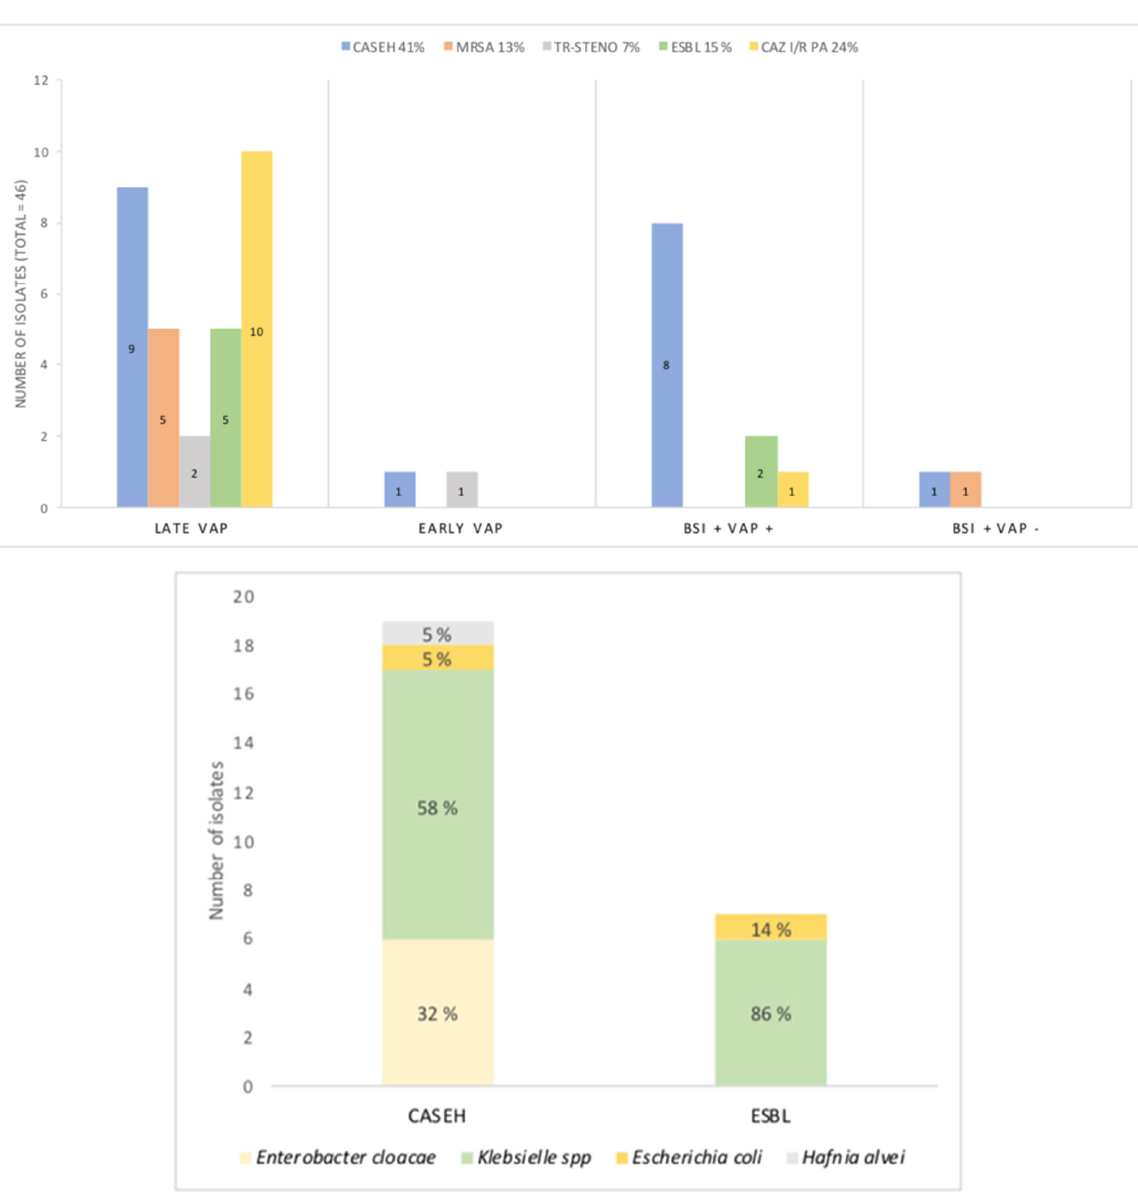
Figure 3. Antibiotic resistance mechanisms according to type of infection and bacteria .